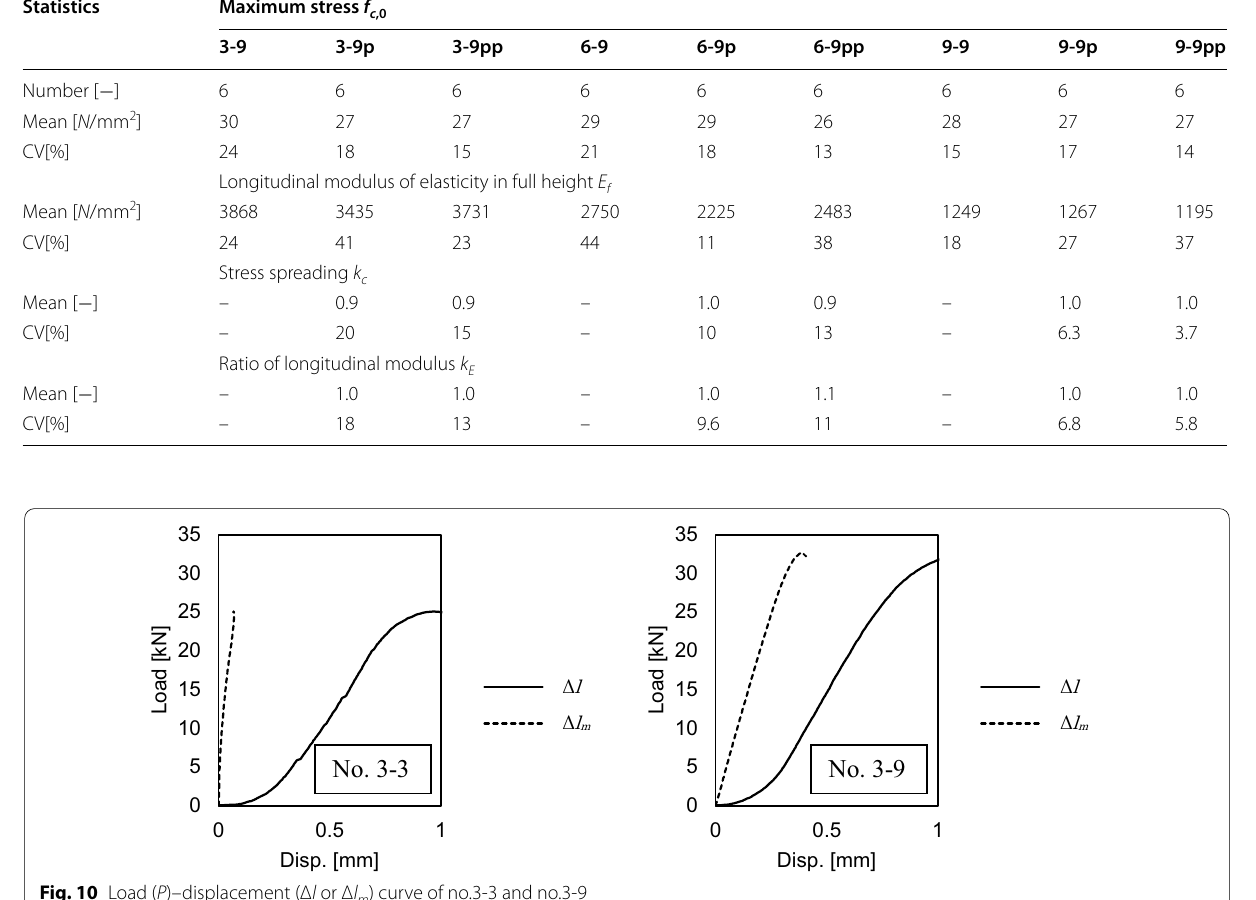
Table 3 Results of estimated parameters and goodness-of-fit tests